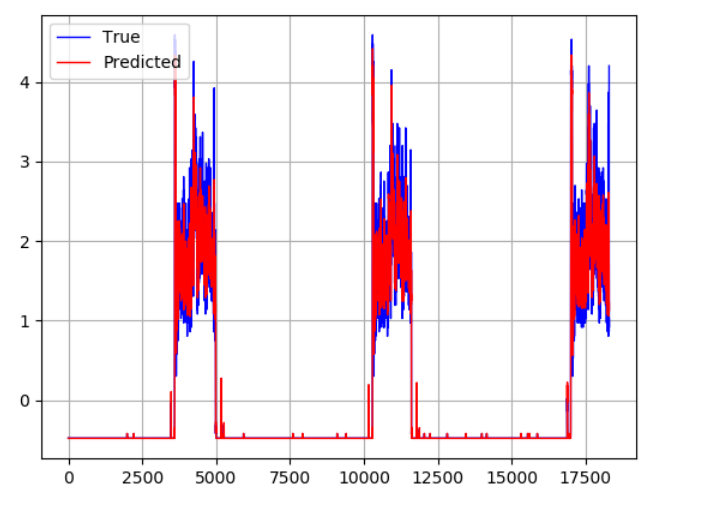
Figure 5. Example of the ARP algorithm result (1).